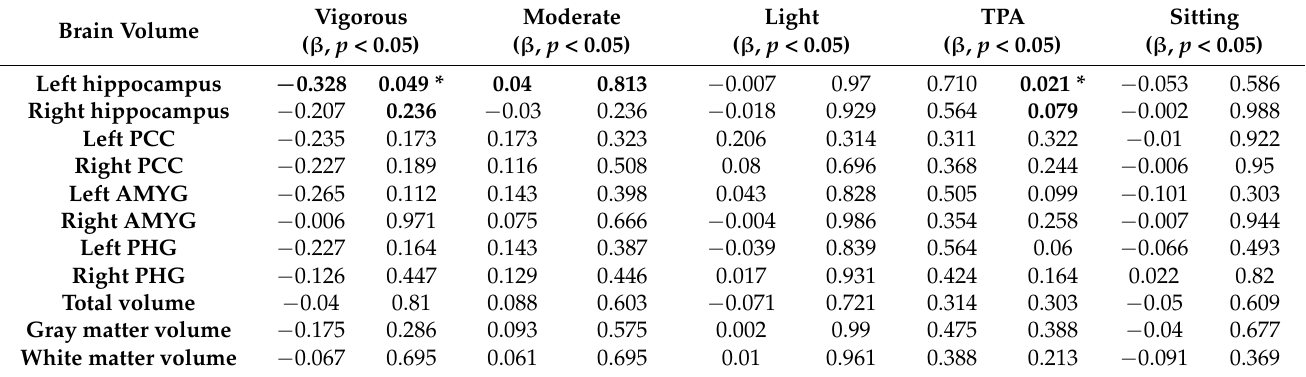
Table 2. Association between brain volume, physical activity, and sedentary